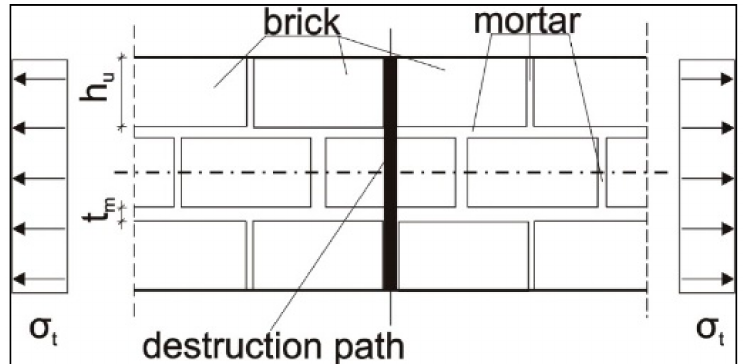
Figure 4. Destruction of the masonry wall sample exposed to axial tension with cracking along the joints and masonry